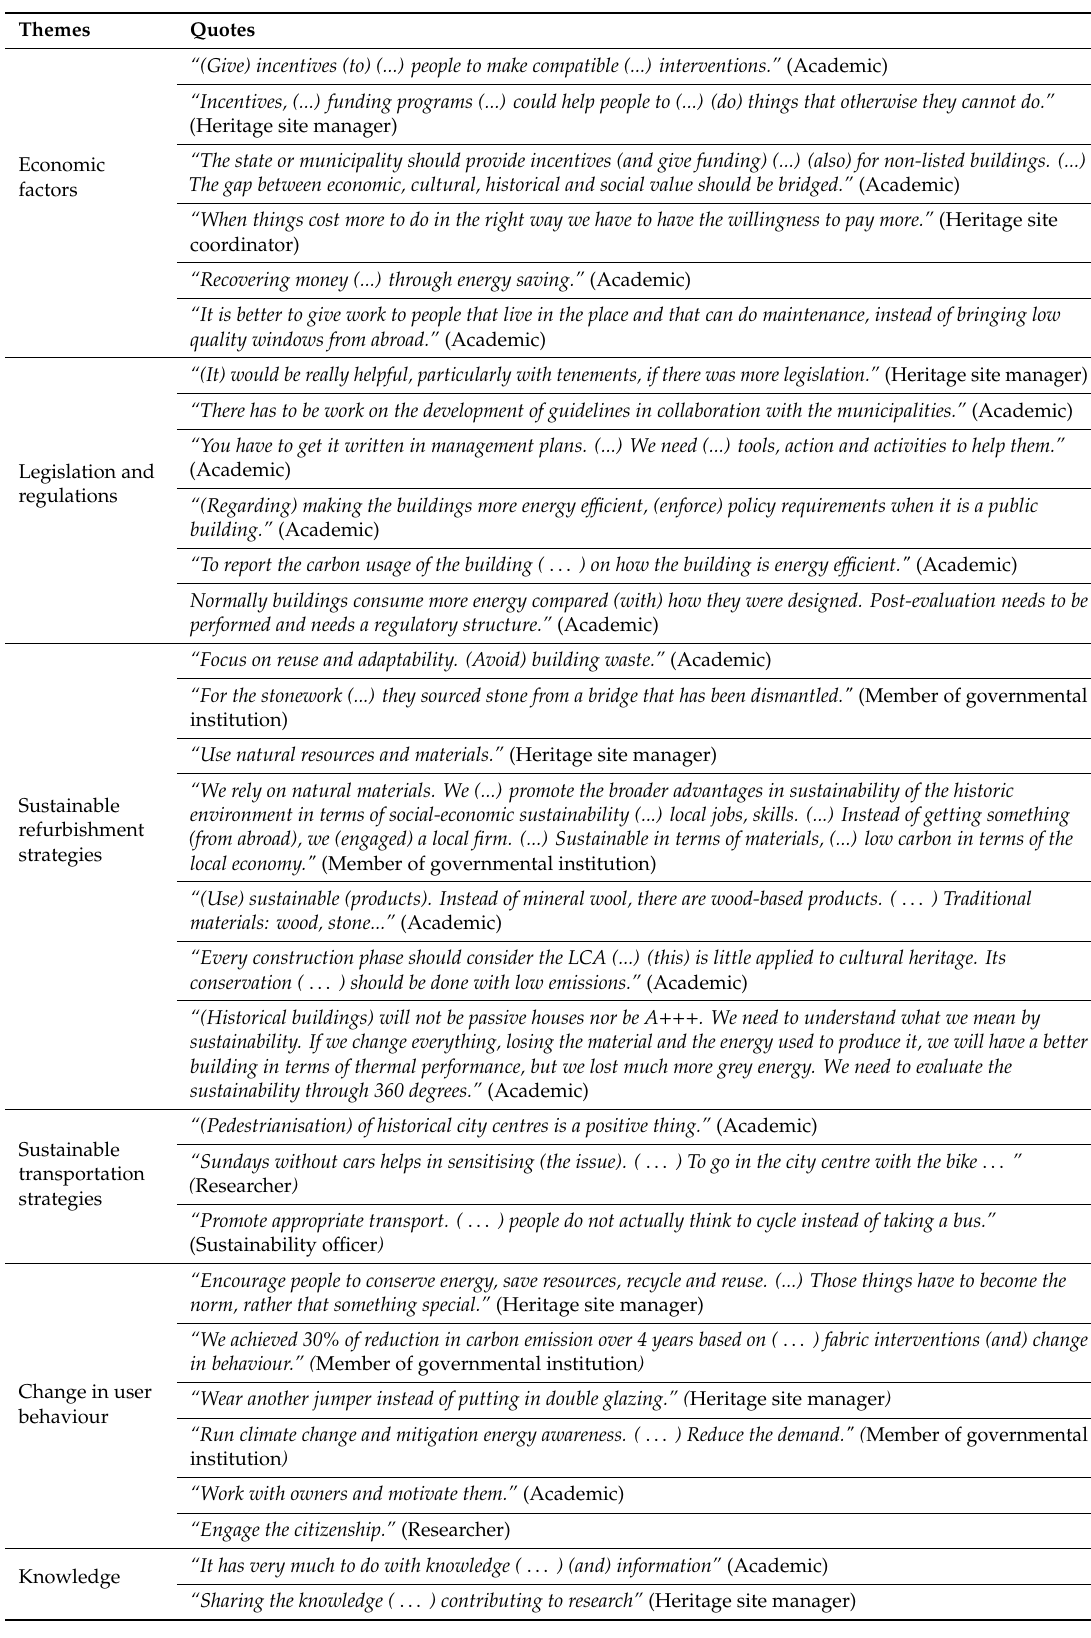
Table 2. Selected quotations in relation to the factors enabling climate change mitigation in the cultural built heritage